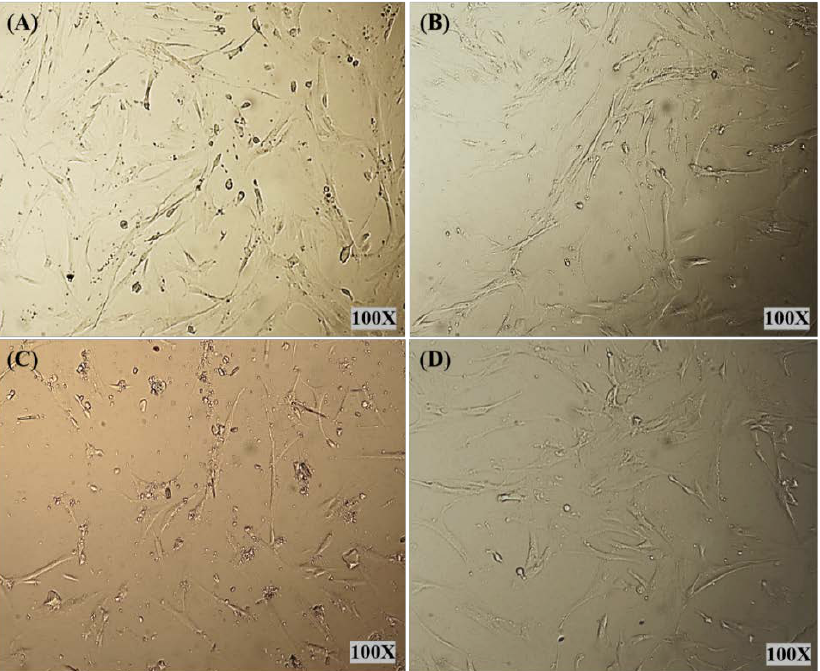
Figure 8. Cell morphology images of HFF-1 cells after 24 h of treatment. HFF-1 cells were treated at a concentration of 37.36 µg/mL with ( A ) control, ( B ) PMMA-NR, ( C ) PMMA-NR-Si-TAM and ( D ) free TAM.